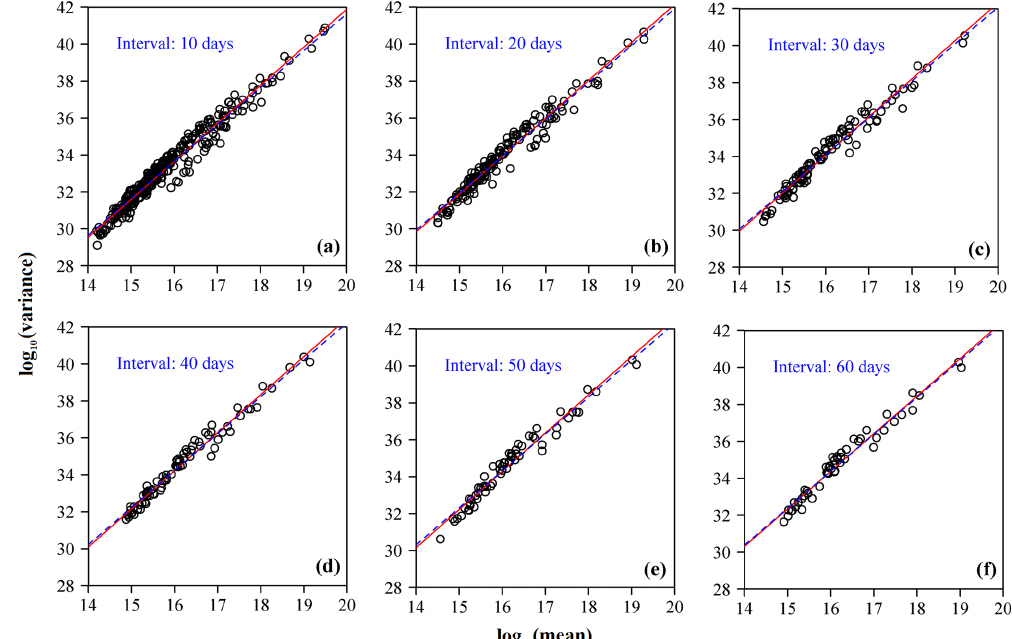
Figure 4. Calculated variance as a function of the observed mean of the energies from earthquakes in each time interval on a log–log coordinate (open circles) for different values of A . The red straight line corresponds to the fitted TPL with an unknown exponent, i.e. log 10 (σ 2 ) = c + b log 10 (µ) , using the least squares method. The blue dashed line corresponds to the fitted TPL with the exponent 2, i.e. log 10 (σ 2 ) = d + 2log 10 (µ) . There are 97 different values of A in total, and only six are shown here: (a) A = 10, (b) A = 20, (c) A = 30, (d) A = 40, (e) A = 50, and (f) A =